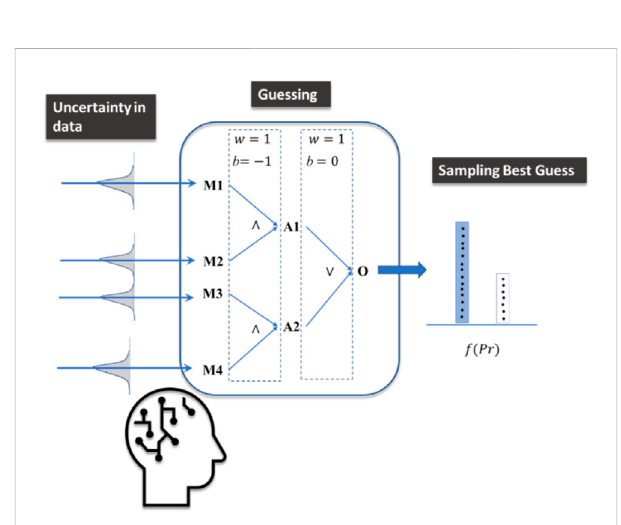
FIGURE 3 The implemented model mimics cognitive processes under uncertainty, where guesses are performed and fi nally sampled considering different options (outputs) to take a fi nal decision. While a decision is made, other alternative answers are not fully